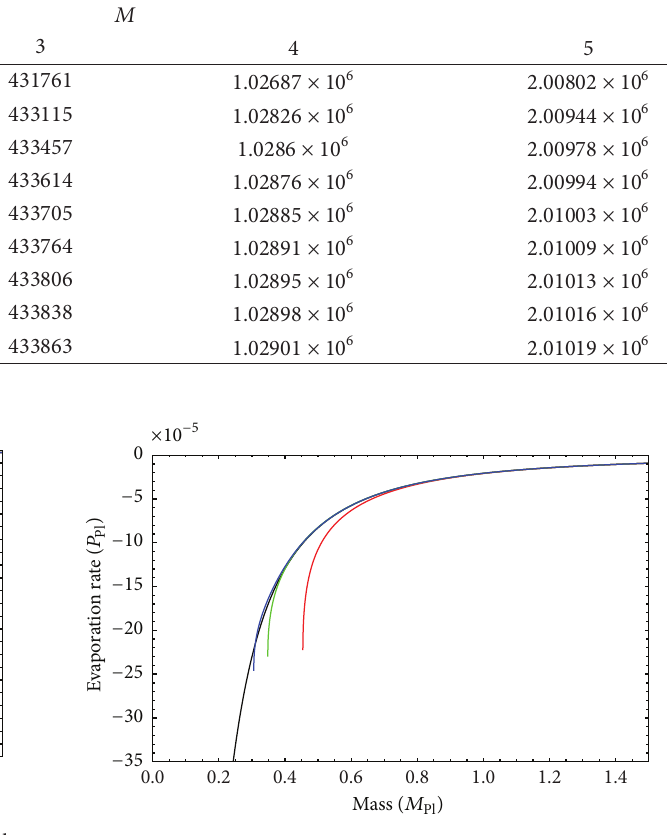
Table 2: GUP 𝑛 -corrected decay time with 𝑛 = 2, 3, .. ., 10 , the black hole mass 𝑀 = 1, 2, .. ., 5 (in Planck units), and 𝛼 = 1 . GUP 𝑛 -corrected decay time without the UV/IR mixing effect